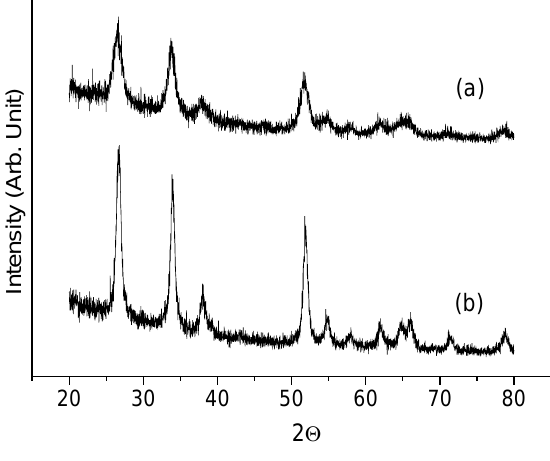
Figure 4. X-ray diffraction pattern of (a) SiO Gas sensing